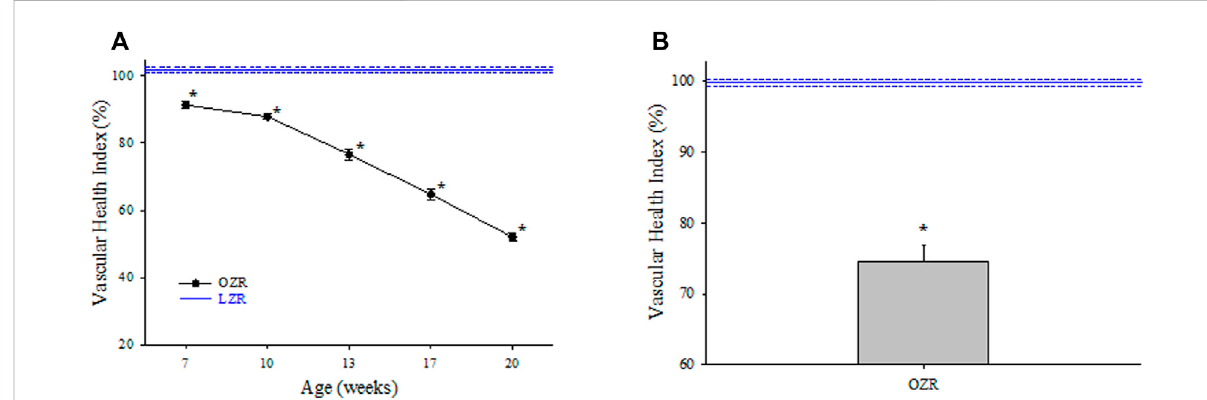
FIGURE 4 Data describing the 5-parameter determination of Vascular Health Index (VHI) within the cerebral microcirculation. Data (mean ± SE) are presented for OZR over the age ranges of the present study (Panel (A) ). Panel (B) presents the aggregate VHI from OZR where all ages have been compiled into one data point. VHI from LZR is set to 100%, by de fi nition. * p < 0.05 vs. LZR at that age. Please see text for details.